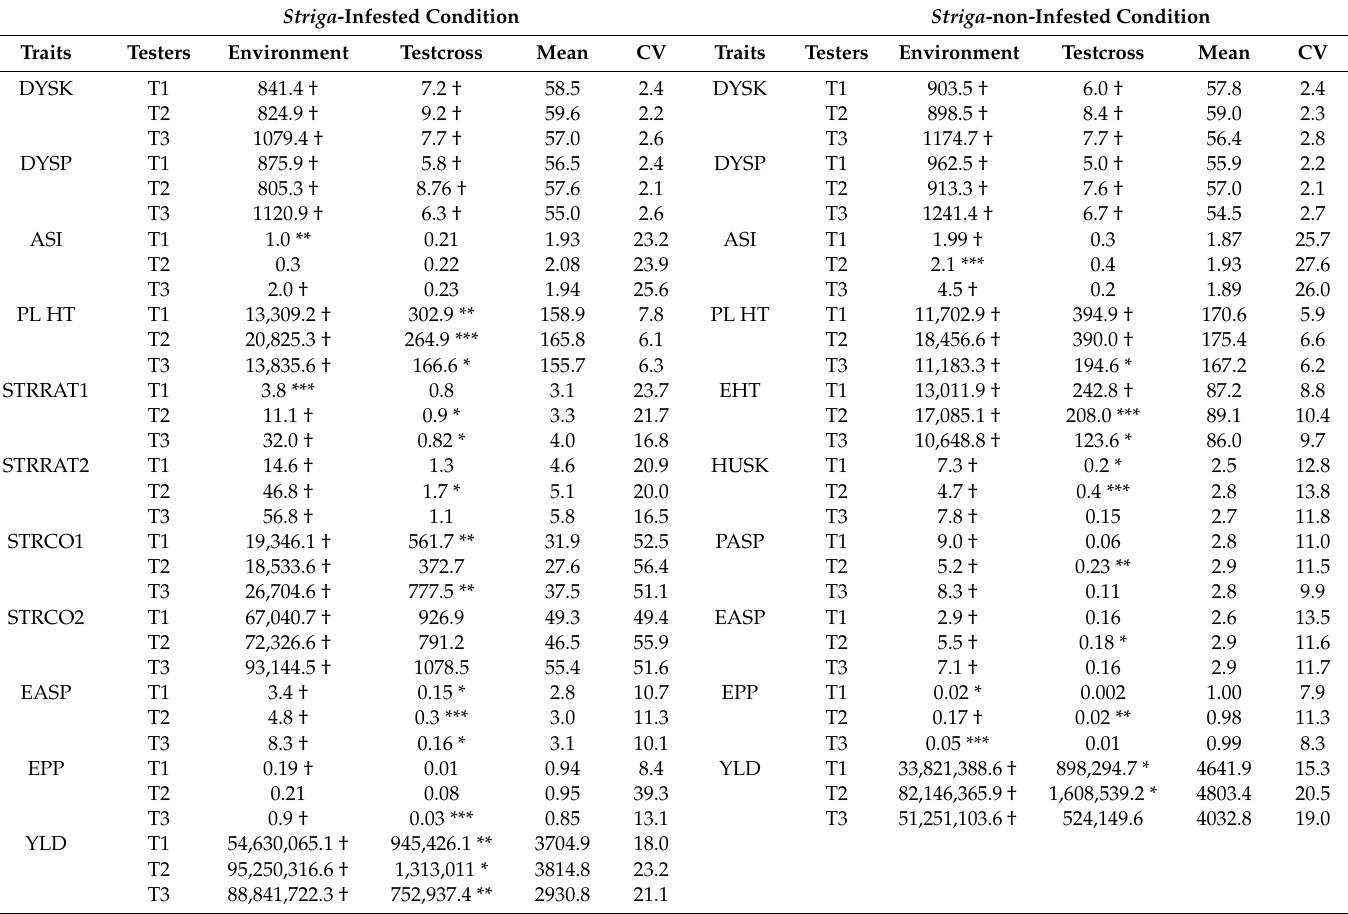
Table A2. Mean squares of testcrosses for each tester across four environments under Striga -infested non-infested conditions. Striga -Infested